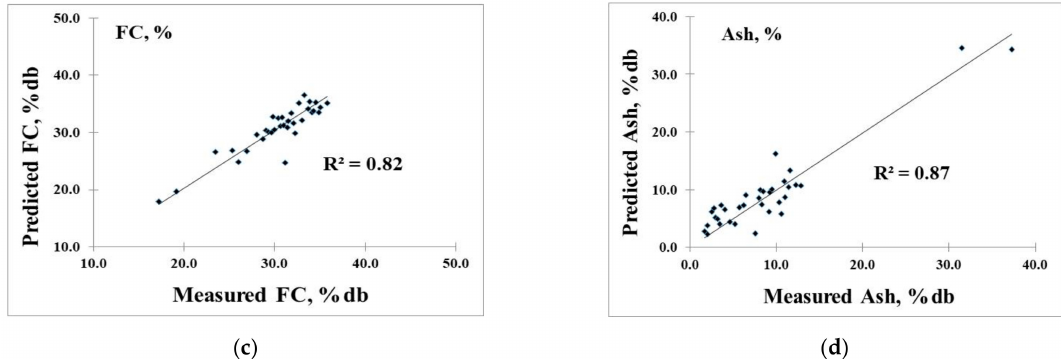
Figure 8. Scatter plots of measured value versus predicted value of 34 biomass pellets in the prediction of ( a ) fuel ratio (FR, %db), ( b ) volatile matter (VM, %db), ( c ) fixed carbon (FC, %db), and ( d ) ash content (A, %db).